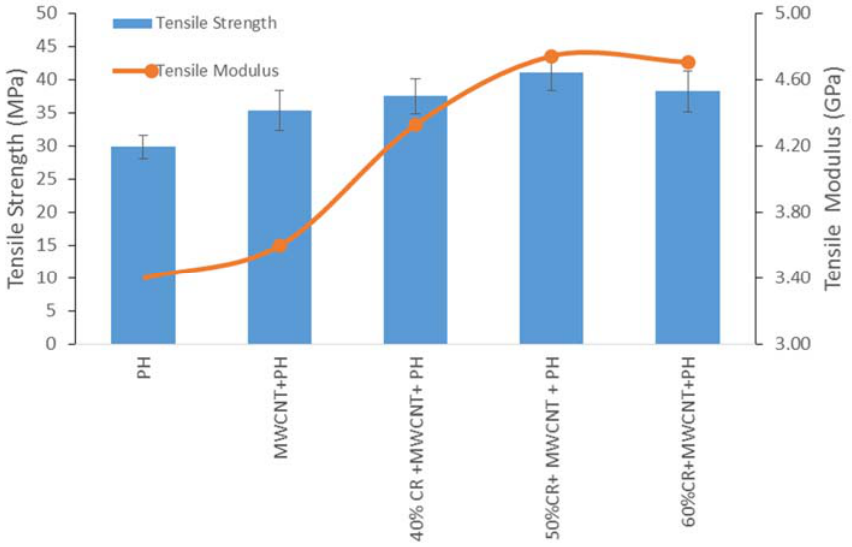
Figure 6. CR fiber loading on tensile strength and Modulus of MWCNT ‐ Phenolic composites.